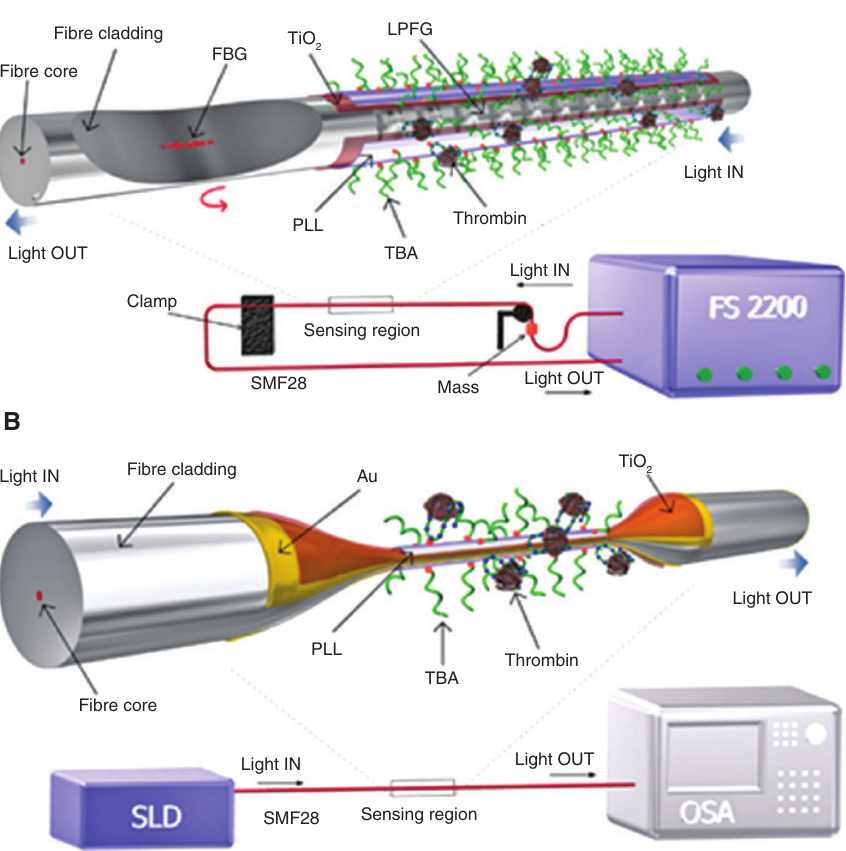
(A) and SPR device in etched single-mode fiber 2